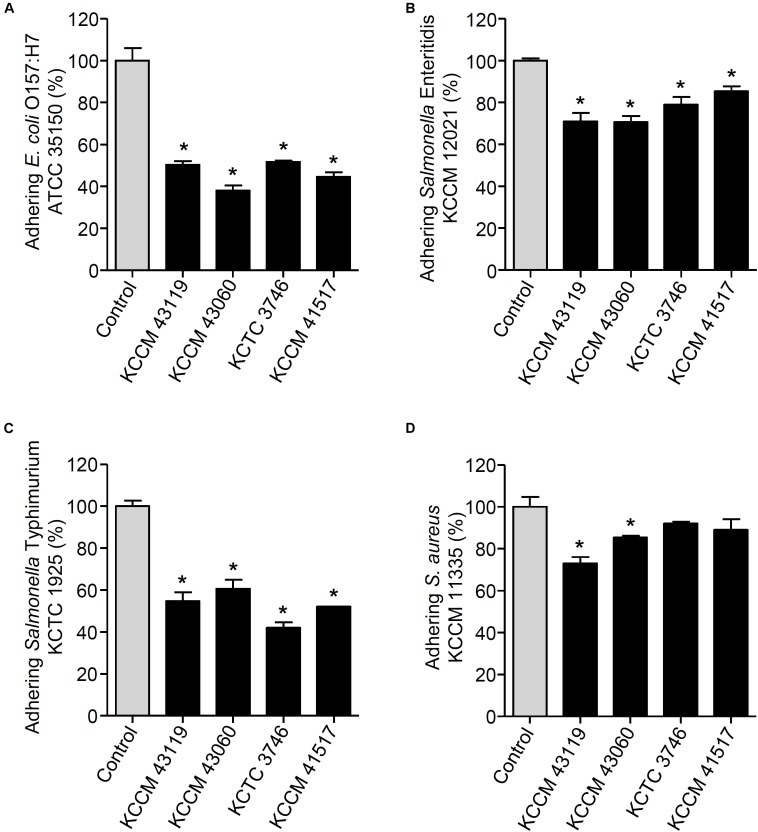
Changes in adhesion of E. coli O157:H7 ATCC 35150 (A), Salmonella Enteritidis KCCM 12021 (B), Salmonella Typhimurium KCTC 1925 (C), or S. aureus KCCM 11335 (D) to HT-29 cells. HT-29 cells were pre-treated with the LAB strains (L. curvatus KCCM 43119, Ln. mesenteroides KCCM 43060, W. cibaria KCTC 3746, or W. koreensis KCCM 41517). After 1 h, the HT-29 cells were treated with the foodborne pathogenic bacteria for an additional 1 h and the adhesion of foodborne pathogenic bacteria was determined. The adhesion of foodborne pathogenic bacteria alone to HT-29 cells was assigned to 100% (control). An asterisk (∗) indicates the statistical significance compared with control (P < 0.05).